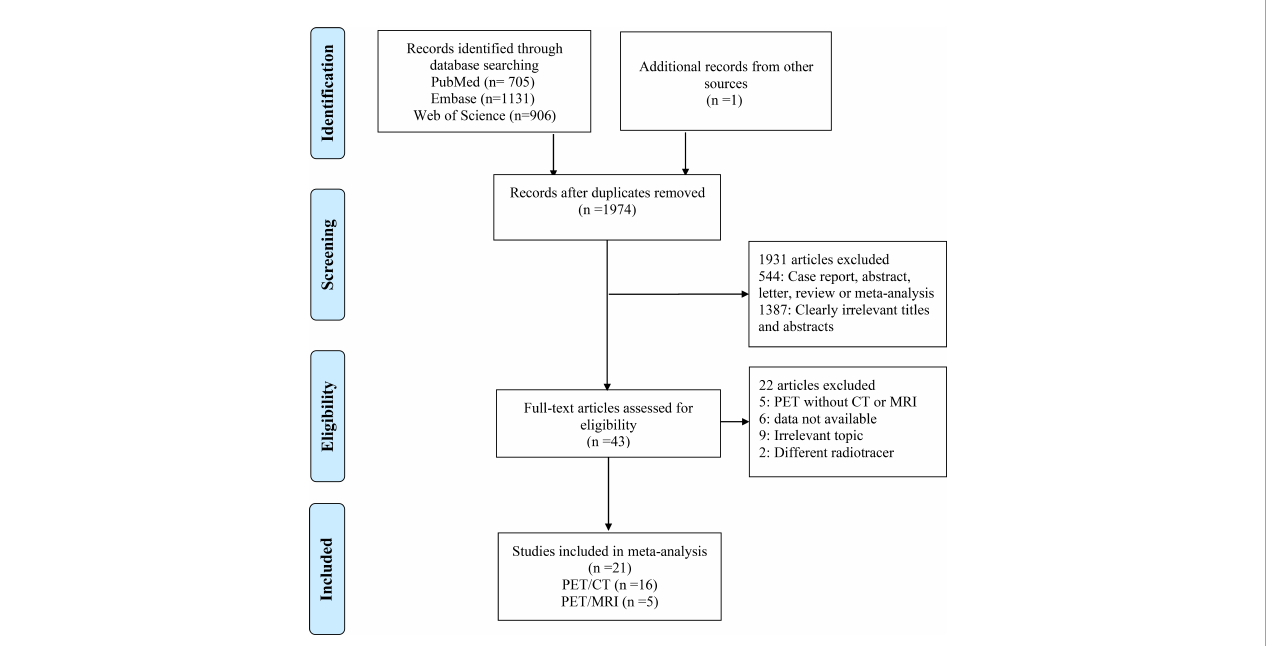
FIGURE 1 The PRISMA fl ow chart of study selection